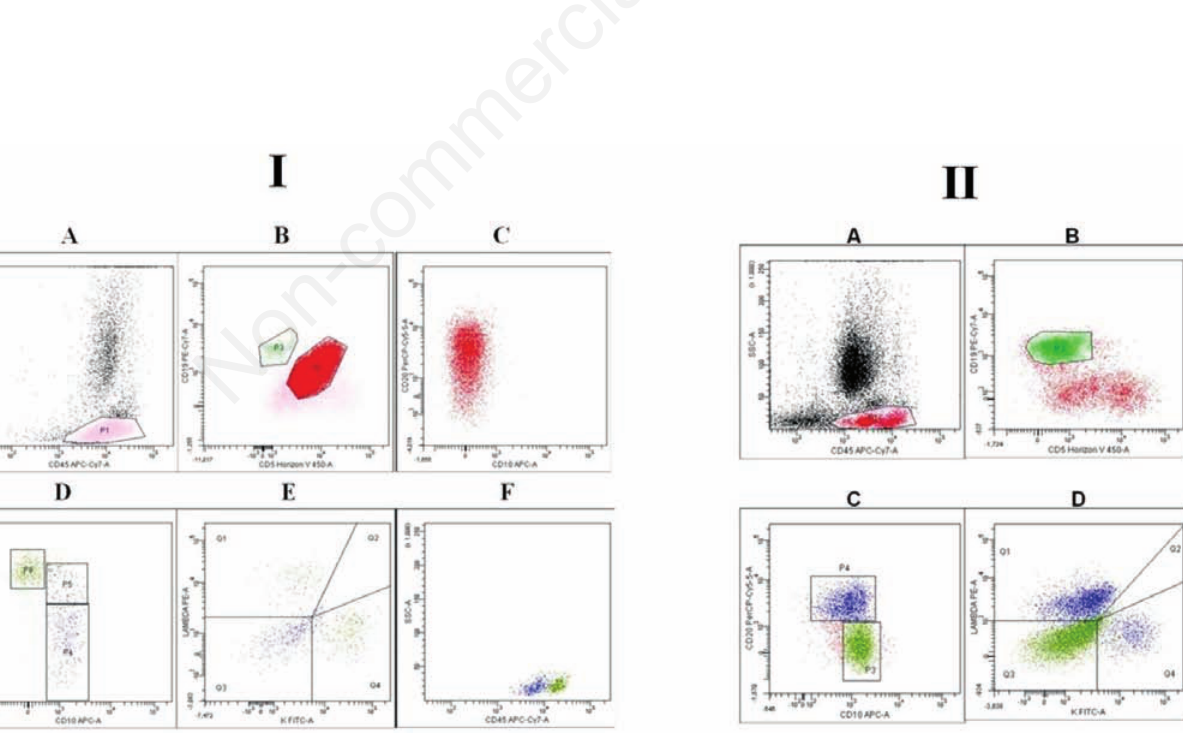
Figure 2. Correlation between hemtogones percentage and degree of bone marrow infil- tration by neoplastic lymphocytes.